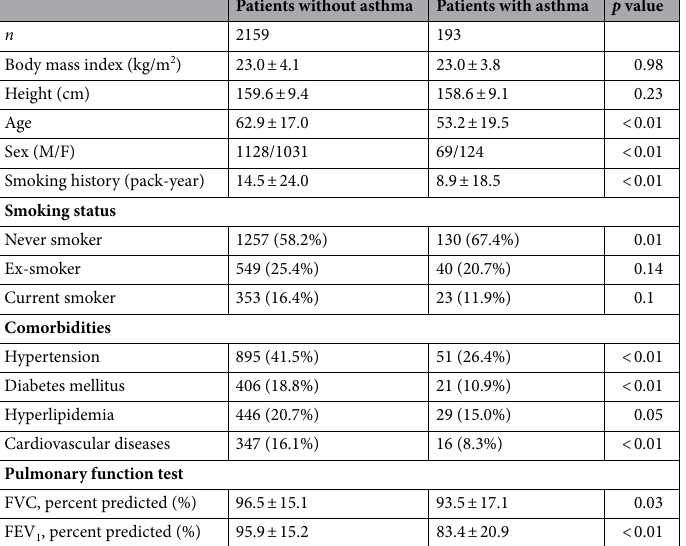
Patients without asthma Patients with asthma p